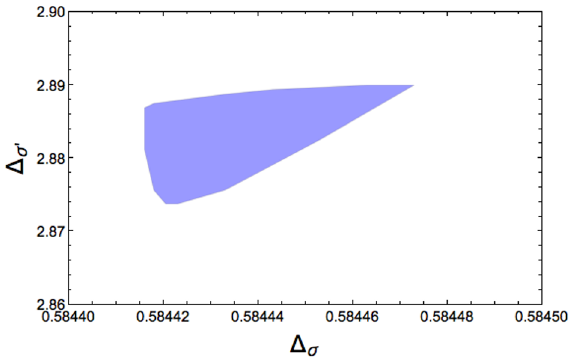
Figure 2 . The region that allows a unitary N = 1 SCFT to exist. We assume that the spectrum contains only one relevant T-parity even operator, and σ and σ 0 are the only two relevant T-parity odd scalar operators. The numerics is performed at Λ = 27